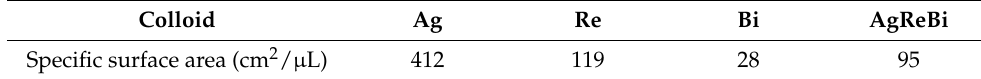
Table 1. Specific surface area of synthesized nanoparticles.